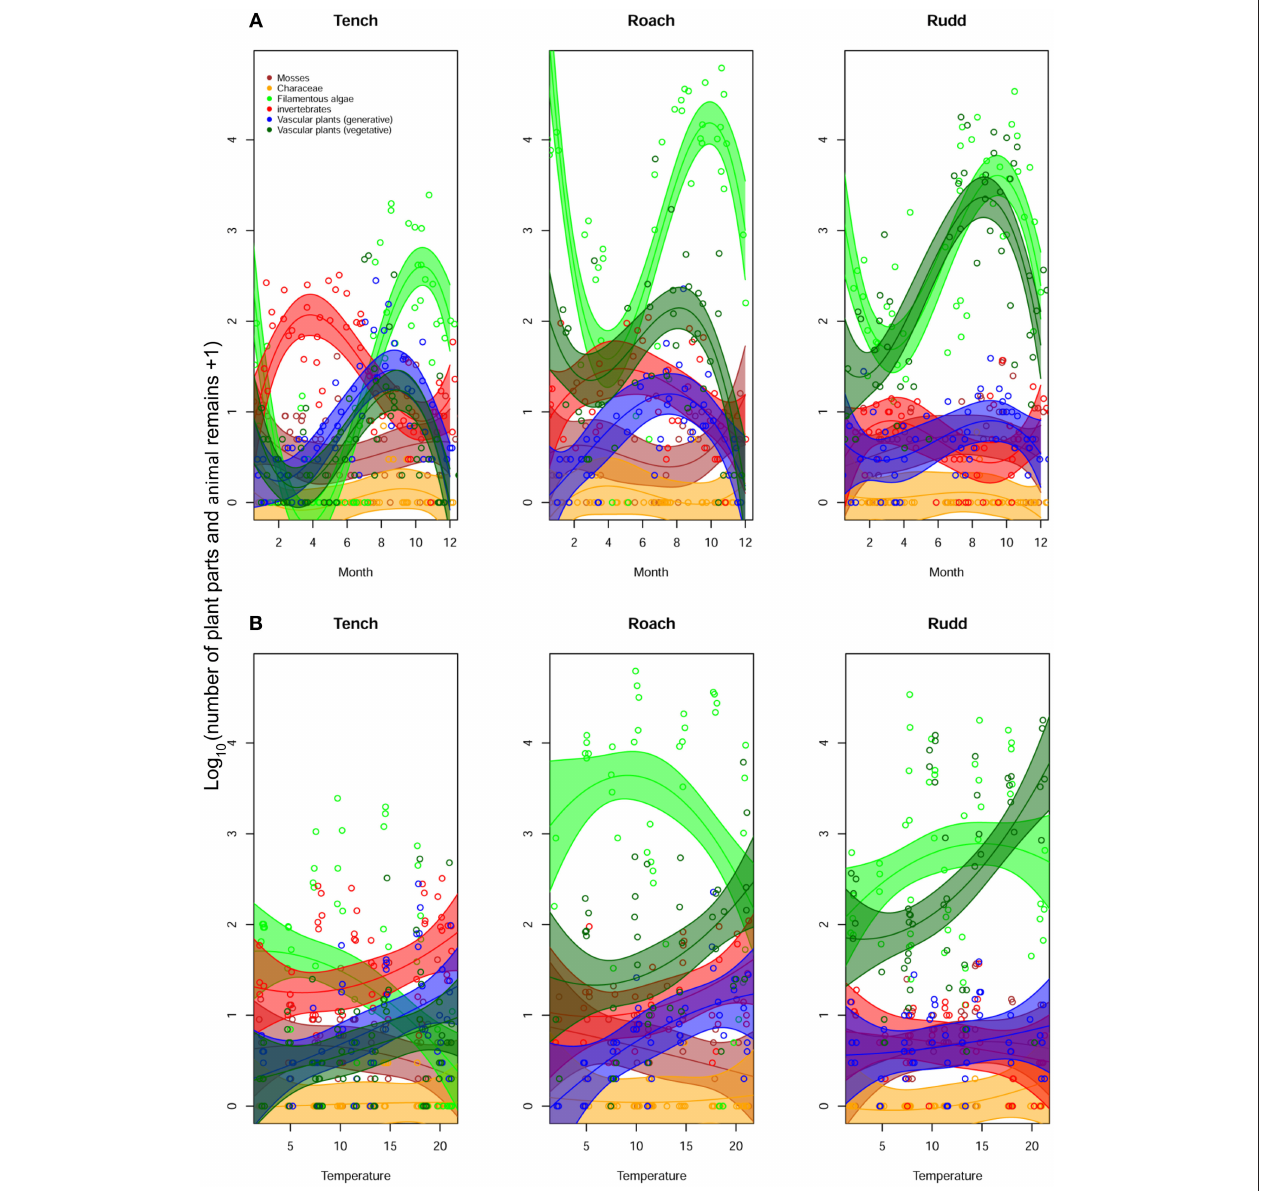
FIGURE 2 | Variation in the number of plant parts and animal remains of taxonomic groups throughout the year (A) , and in relation to water temperature (B) for each of the three fish species.